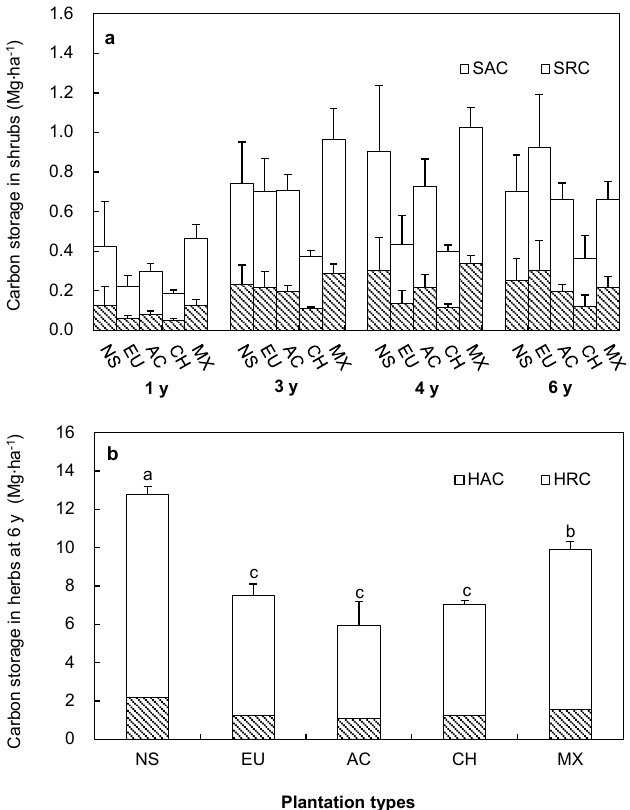
Figure 2. ( a ) Understory shrub carbon storage and allocation along a